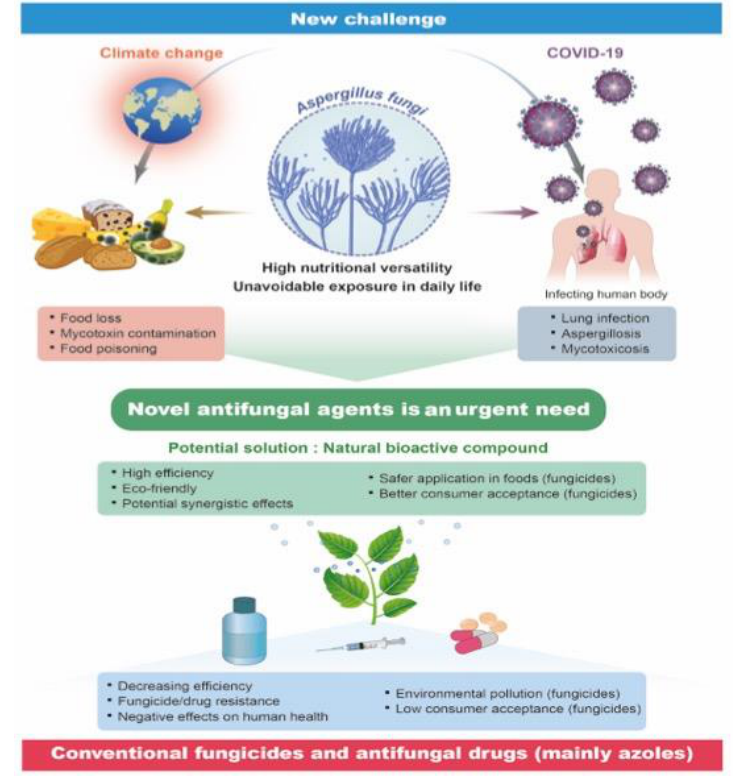
Figure 1. A schematic of the threat posed by Aspergillus flavus and the current measures available to combat it.